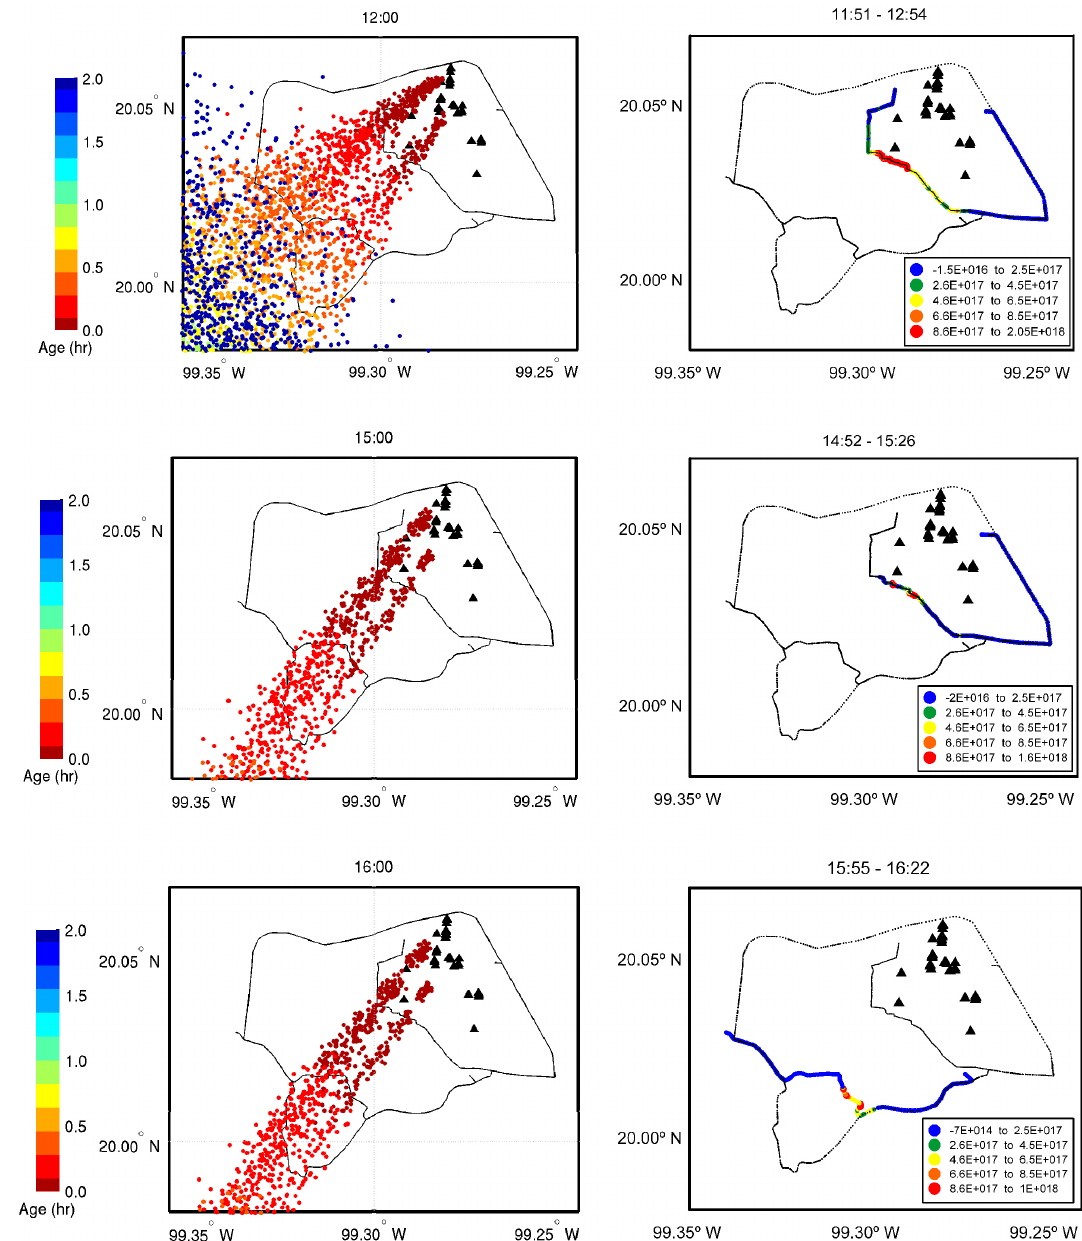
Fig. 6. Comparison between modeled plumes (left) and observed spatial distribution of SO 2 columns (right) during 4 April 2006. Known sources of the power plant and refinery are shown with black triangles. The units of the differential vertical SO 2 columns are molecules/cm 2